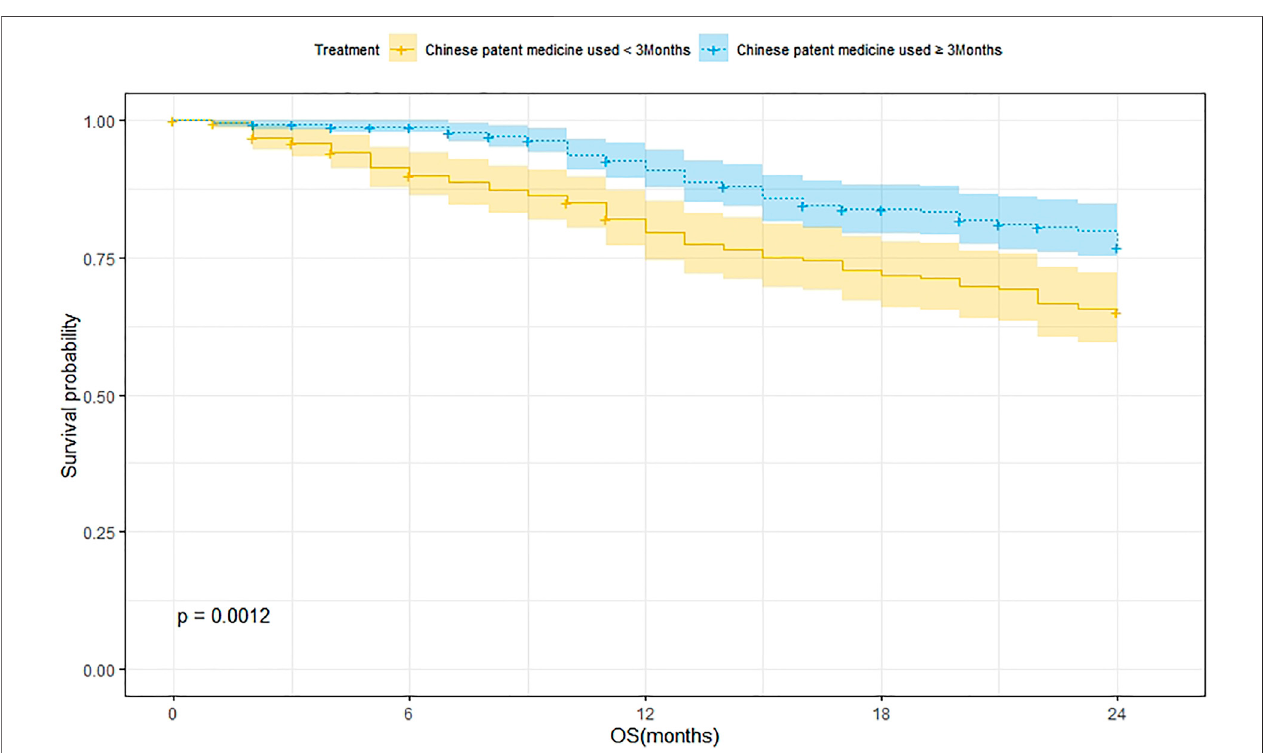
FIGURE 2 | Survival analysis of patients treated with CPM for < 3 months and patients treated with CPM for ≥ 3 months.